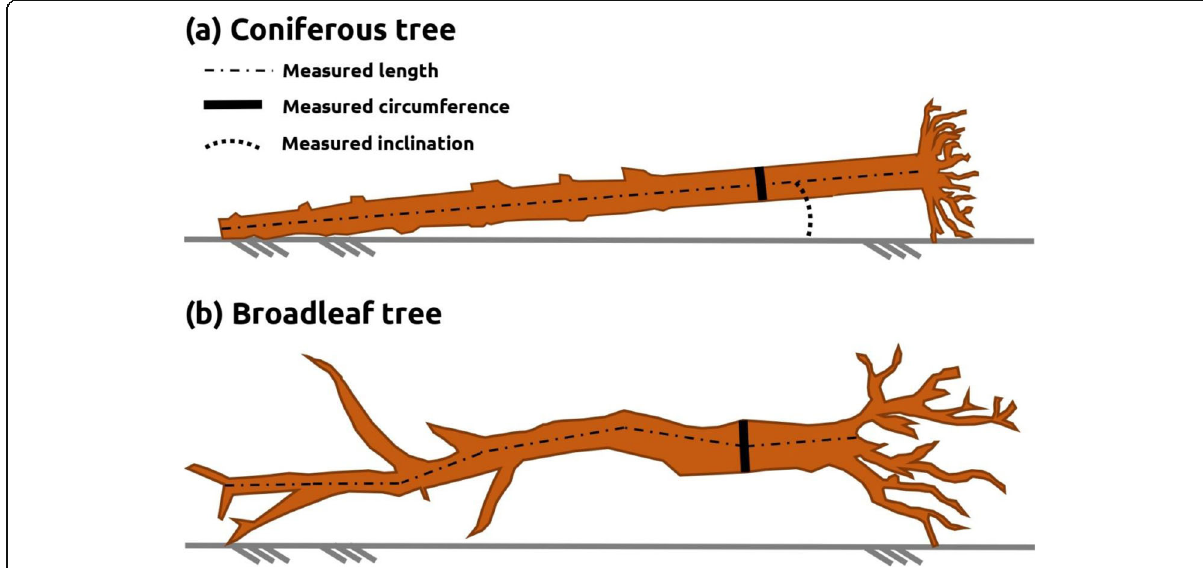
Fig. 3 Schematic representation of the components for the direct measurement of wood pieces: a the coniferous tree and b broadleaf tree. The left side indicates the top of each type of tree (the side of the tree crown). The right side depicts the root